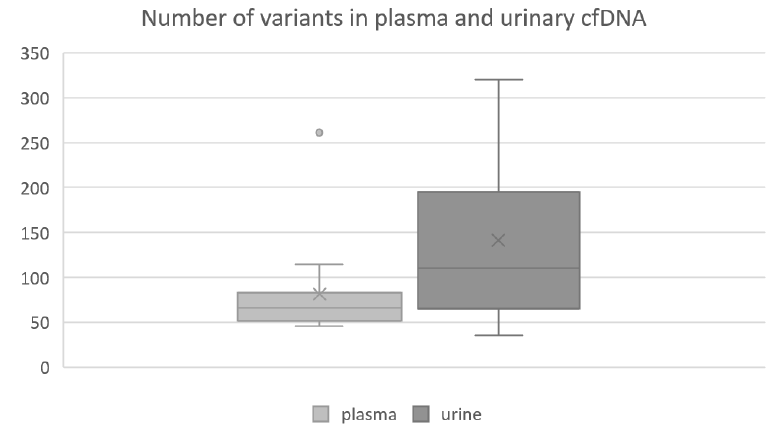
Figure 2. Boxplot showing the number of variants found in plasma and urinary ctDNA. Per plasma sample, a median number of 66 variants were found in ctDNA, ranging from 46 to 261 variants. In contrast, a median number of 110 variants were obtained per urinary ctDNA sample, ranging from 36 to 320 variants. Medians and interquartile ranges are displayed. The mean value is marked with an x.